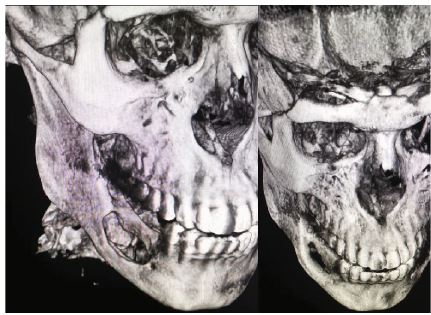
Figure 6: Preoperative and one-year postoperative 3D CT scan. Table 1: Comparing the previously published case with our